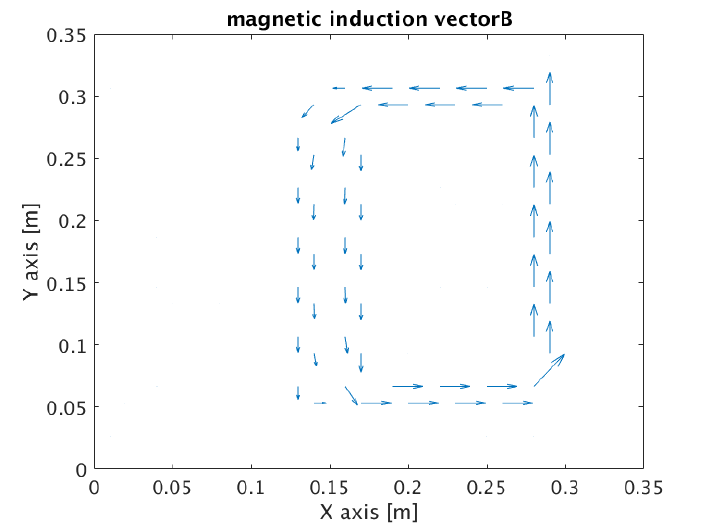
Figure 8. The distribution of the magnetic flux density vector in the cross-sectional area of the choke for angular frequencies ω = 3141.6 rad and time t = 0.1 s s